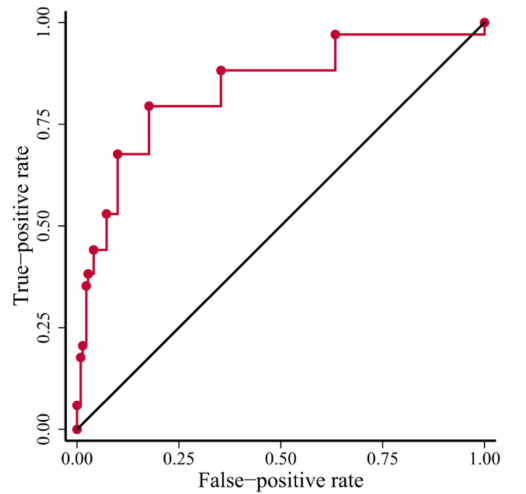
Figure 3. ROC curve of TD score to predict a BRCA1-type BC. Diagonal black line indicates a diagnostic test with performance no better than chance.